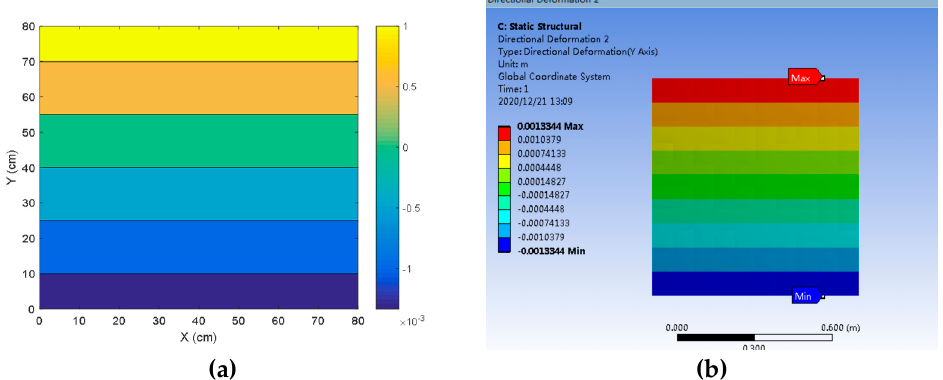
Figure 12. Thermoelasticity calculation results of y direction displacement (( a ) FEMN solution and ( b ) analytical solution).